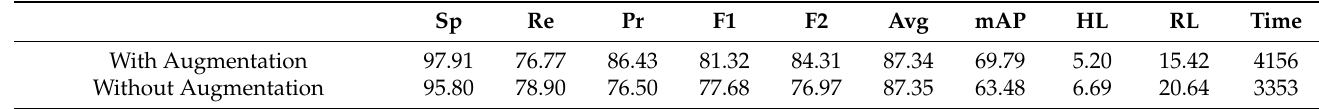
Table 3. Results of Civezzano multi-label